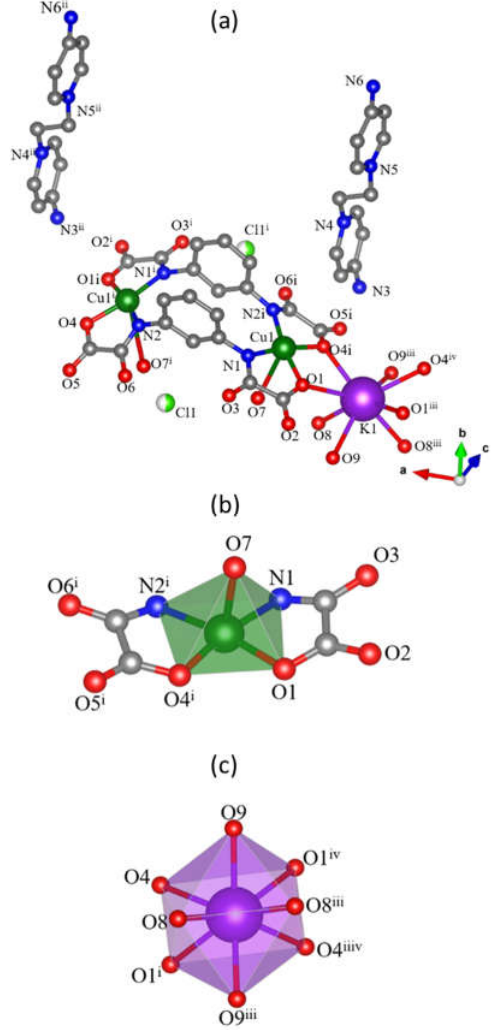
Figure 3. ( a ) Representation of a fragment of the structure of 2 . Carbon and hydrogen atoms are displayed as dark and pale gray spheres. Two chlorine atoms are present since each position is equivalent to half of the occupancy for this atom. Crystallization water molecules are hidden for the sake of clarity [symmetry code: (i) = 5/2 − x , y , 2 − z ; (ii) = 5/2 − x , –1/2 − y , 3/2 − z ; (iii) = 3/2 − x , y , 2 − z ; (iv) = − 1 + x , y , z ]. ( b ) Coordination polyhedron of the copper atom. ( c ) Coordination polyhedron of the potassium atom.